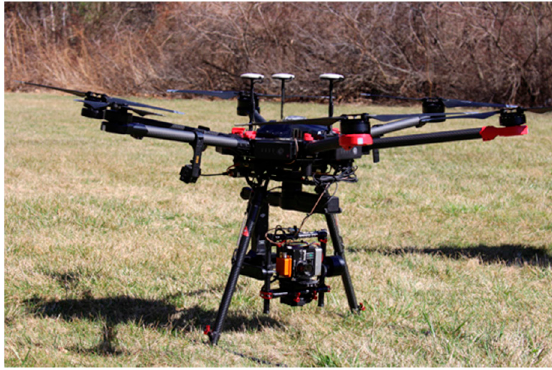
Figure 2. Photograph of UAV hyperspectral imaging system.